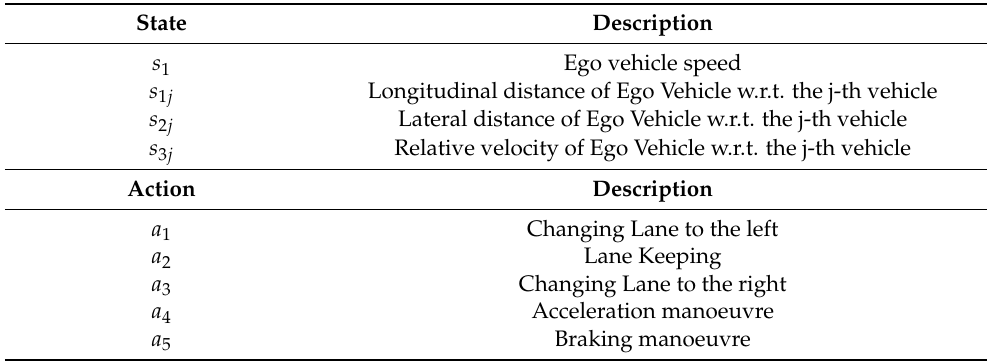
Table 1. State and action spaces for the DDQN agent driving the Ego vehicle. State Description s